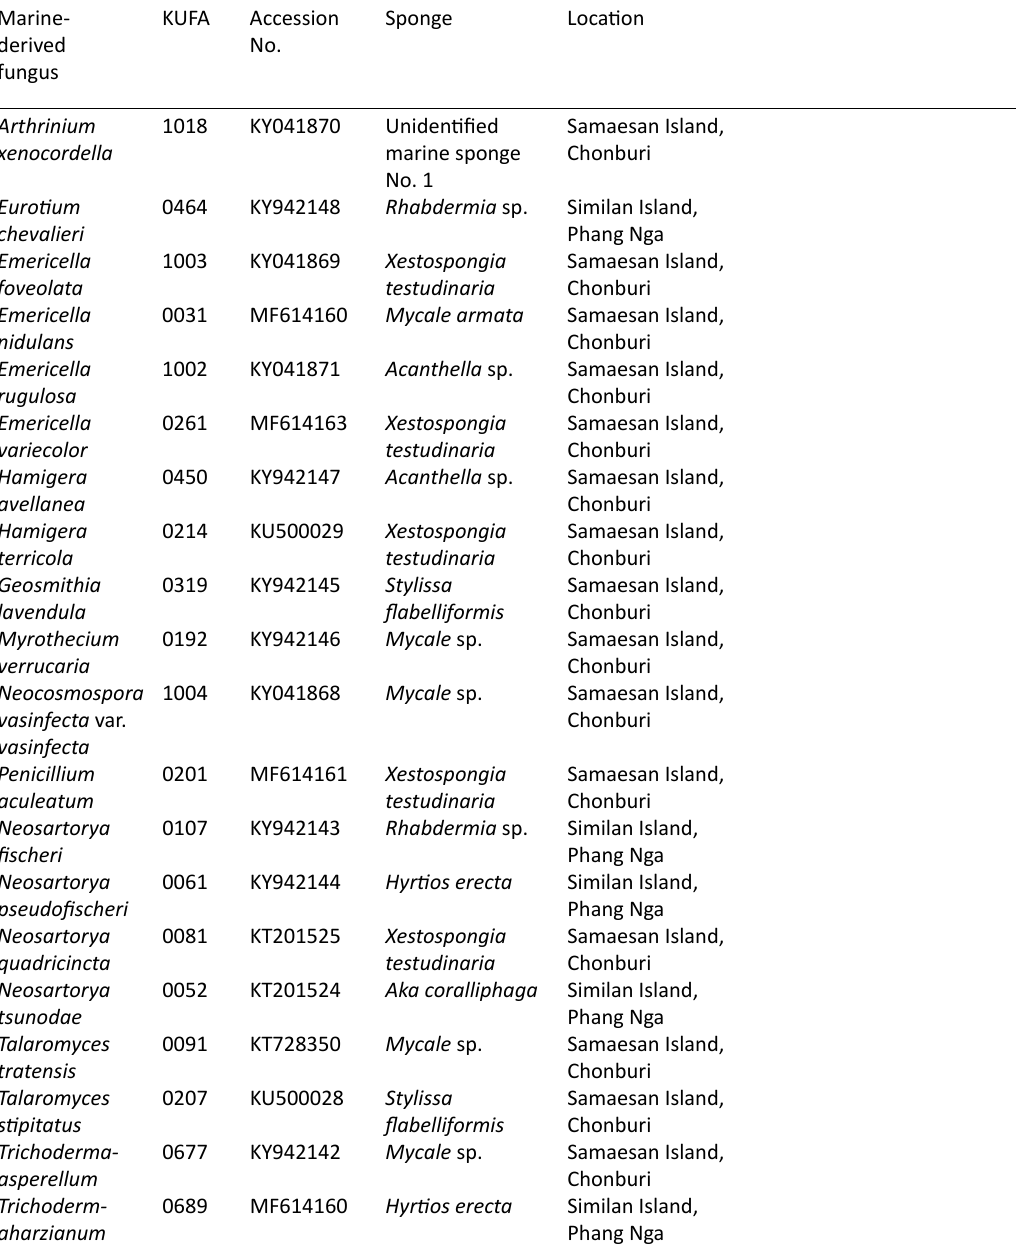
table 1. Fungi isolated from marine invertebrates used in this study Marine- KUFA Sponge Location derived